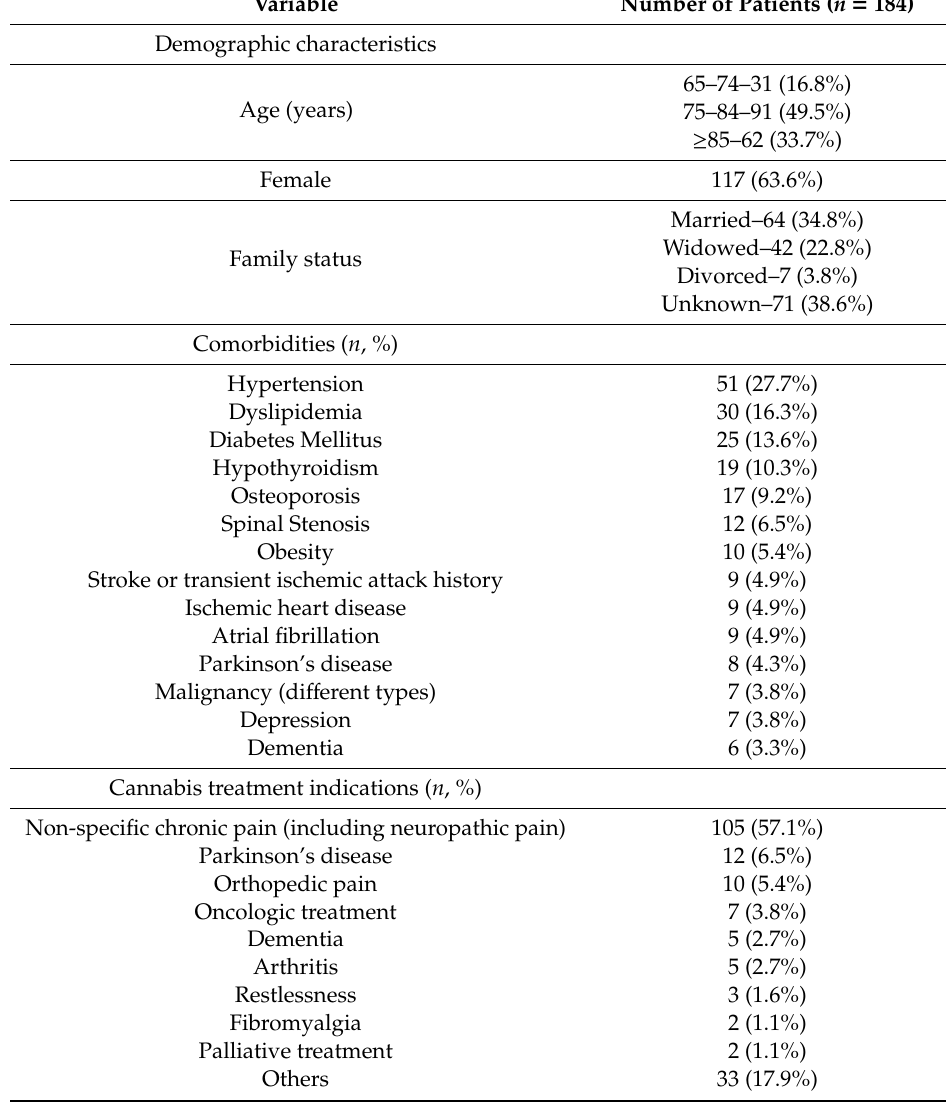
Table 1. Demographic characteristics, indication for cannabis treatment, and comorbidities of the patients treated with medical